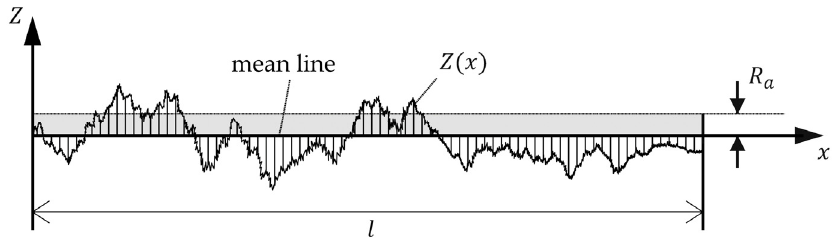
Figure 1. Profile line of a technical surface which is composed of multiple orders of shape devia- tions.